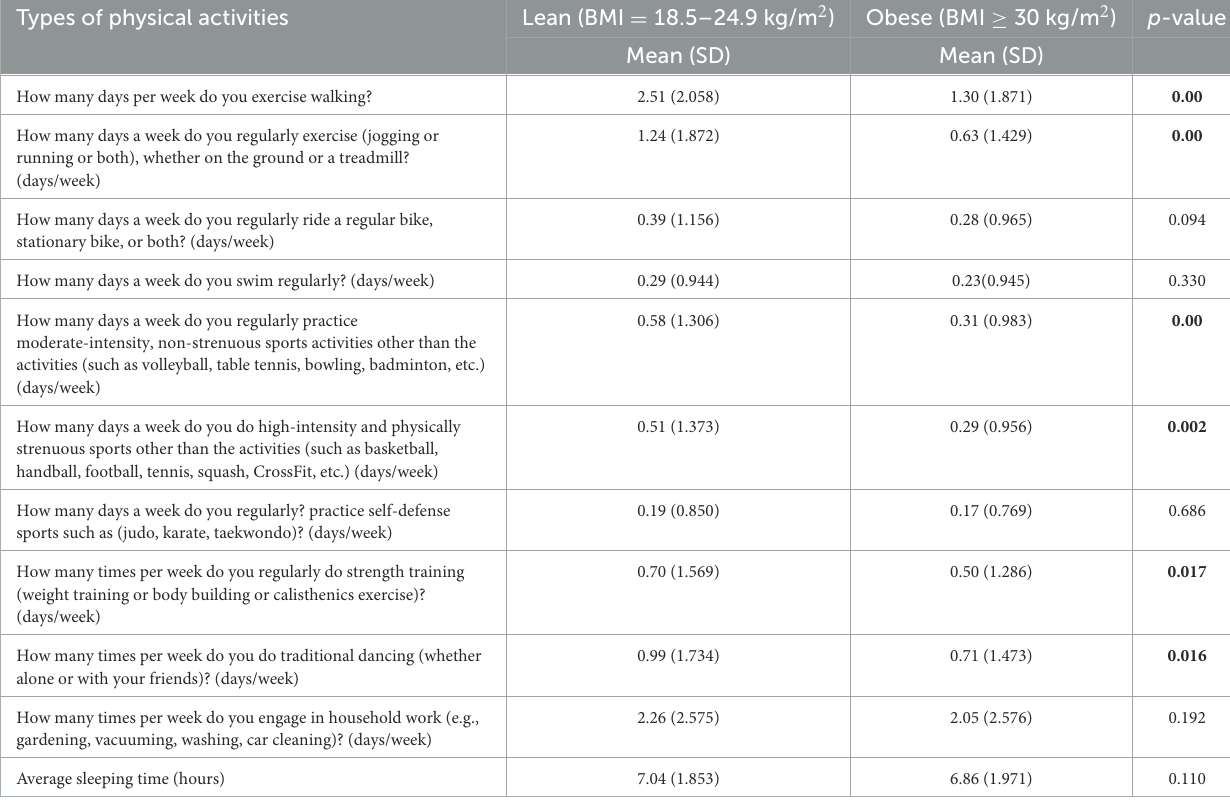
TABLE 4 Comparison of different types of physical activity in lean and obese subjects. Types of physical